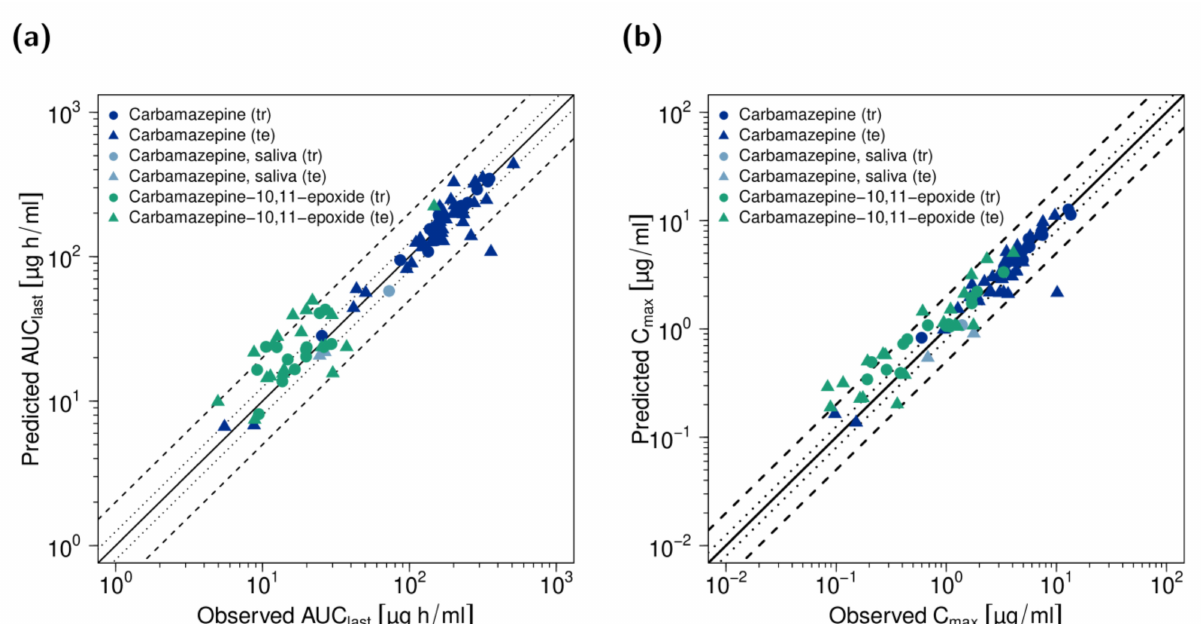
Figure 3. Performance of the carbamazepine parent − metabolite PBPK model. Predicted compared to observed ( a ) AUC last values and ( b ) C max values of carbamazepine and carbamazepine-10,11-epoxide of all analyzed studies. The line of identity is shown as solid line; 1.25-fold deviation is shown as dotted lines; 2-fold deviation is shown as dashed lines. AUC last : area under the plasma concentration − time curve from dosing to the last concentration measurement, C max : maximum plasma concentration, te: test dataset, tr: training